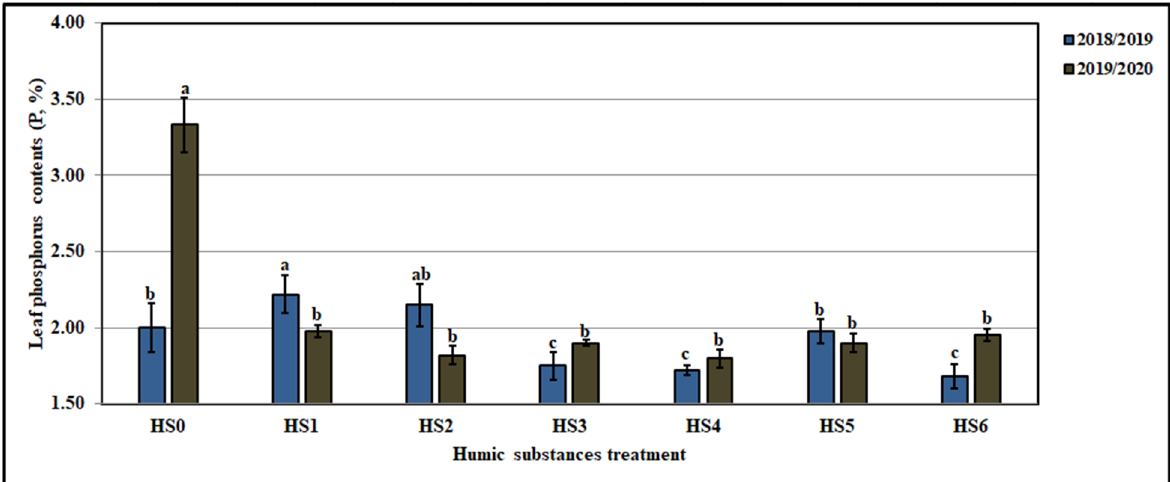
Figure 19. Influence of humic substances treatments on leaf nitrogen contents (N, %) of some wheat varieties grown in clay loam soil in 2018/2019 and 2019/2020 seasons. Bars in the same years with a different letter indicate significant differences between treatments at p ≤ 0.01. HS 1, HS 2 , HS 3 repre- sent HS applied as foliar spray at 1.0, 2.0, 4.0 g L − 1 , respectively, HS 4 , HS 5 , HS 6 represent HS applied as soil application at 5.04, 7.56, 10.08 kg ha − 1 .